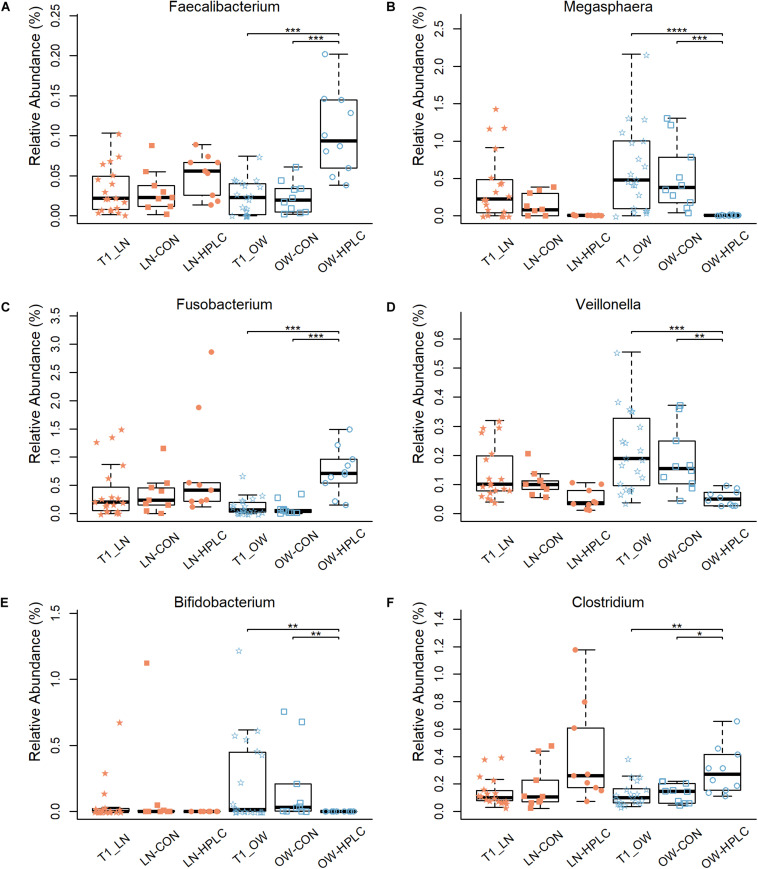
Differences in relative abundance of six bacterial genera: (A–F)
Faecalibacterium, Megasphaera, Fusobacterium, Veillonella, Bifidobacterium, and Clostridium. Samples are from the T2 time point unless indicated otherwise. LN, lean cats; OW, overweight or obese cats; HPLC, high-protein, low-carbohydrate diet; CON, control diet. P-values were corrected for multiple testing (FDR): *FDR < 0.05, **FDR < 0.01, ***FDR < 0.001, ****FDR < 0.0001.